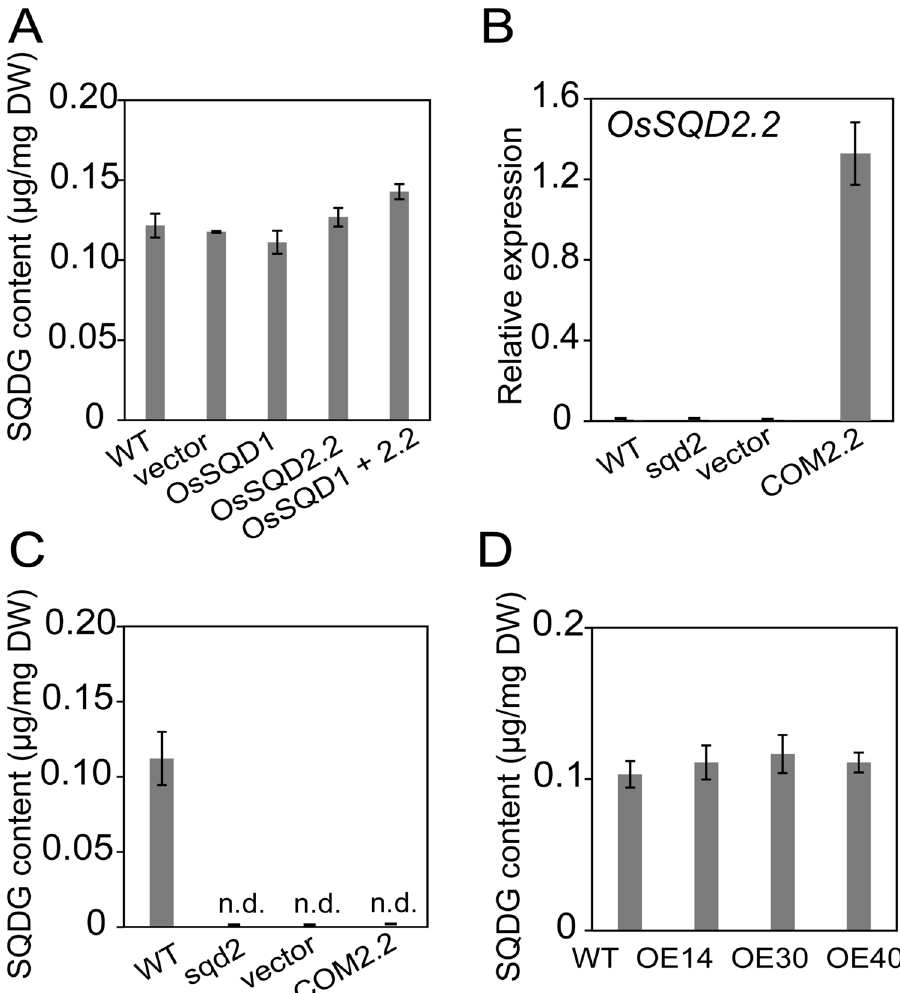
Figure 3. SQD2.2 has no detectable SQDG synthase activity. ( A ) Co-expression of SQD1 and SQD2.2 in tobacco leaves did not result in elevated SQDG content relative to the controls, WT, vector and leaves transformed with either SQD1 or SQD2.2 individually. Values are the mean ± SE (n = 3). ( B ) and ( C ) Genetic complementation with rice SQD2.2 in the Arabidopsis sqd2 mutant failed to restore SQDG synthesis. Lipids were extracted from the leaves of four-week-old seedlings and separated by TLC for GC measurement. Values are the mean ± SE (n = 3). COM2.1, COM2.1, the plants that were genetically complemented with rice SQD2.1 and SQD2.2 , respectively, in the Arabidopsis At sqd2 mutant. n.d., not detectable. ( D ) Overexpression of SQD2.2 in rice plants did not increase SQDG content relative to WT plants. Lipids were extracted from leaves at the seed filling stage. Values are the mean ± SE (n =